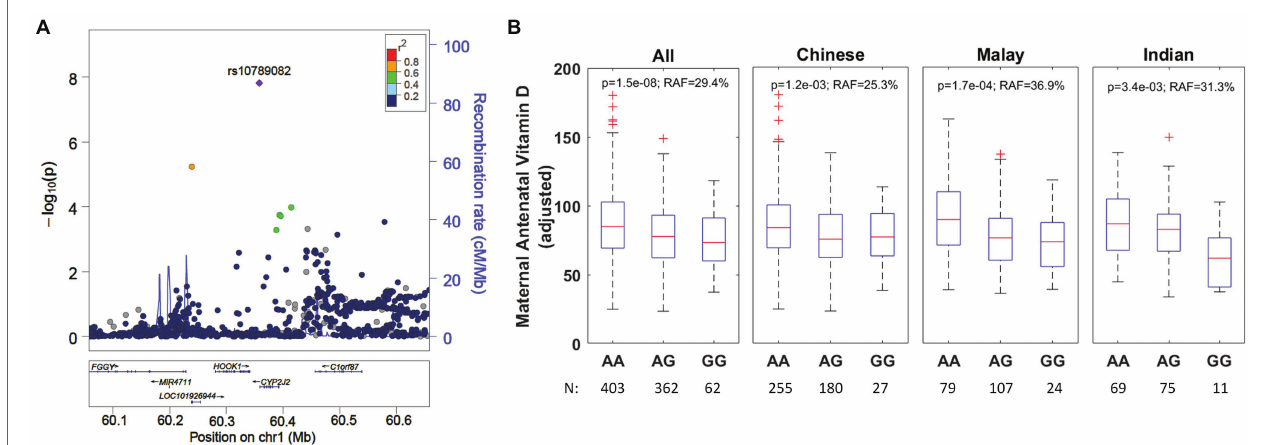
FIGURE 3 | (A) Regional association plot for rs10789082 ( CYP2J2 ) and ethnicity-stratified levels for antenatal vitamin D. The regional association plot is based on all individuals with complete data for analysis. (B) Boxplots adjusted for ethnicity, mother’s age at recruitment, and consumption of vitamin D containing supplements. RAF, risk allele